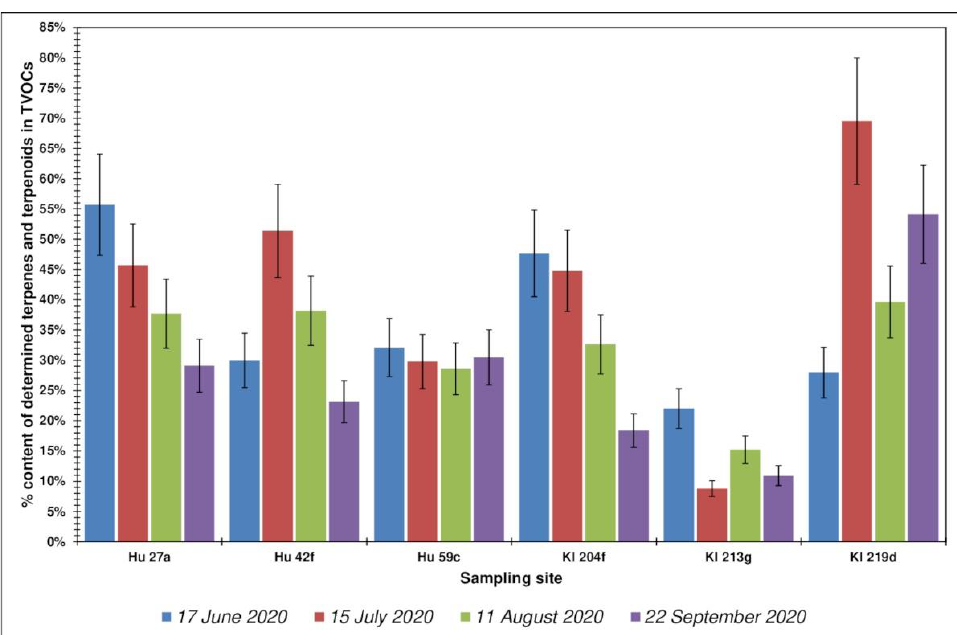
Figure 3. Distribution of concentrations of the sum of terpenes and terpenoids for each test site, over all measurement periods. Error bars express the standard deviation of obtained results.